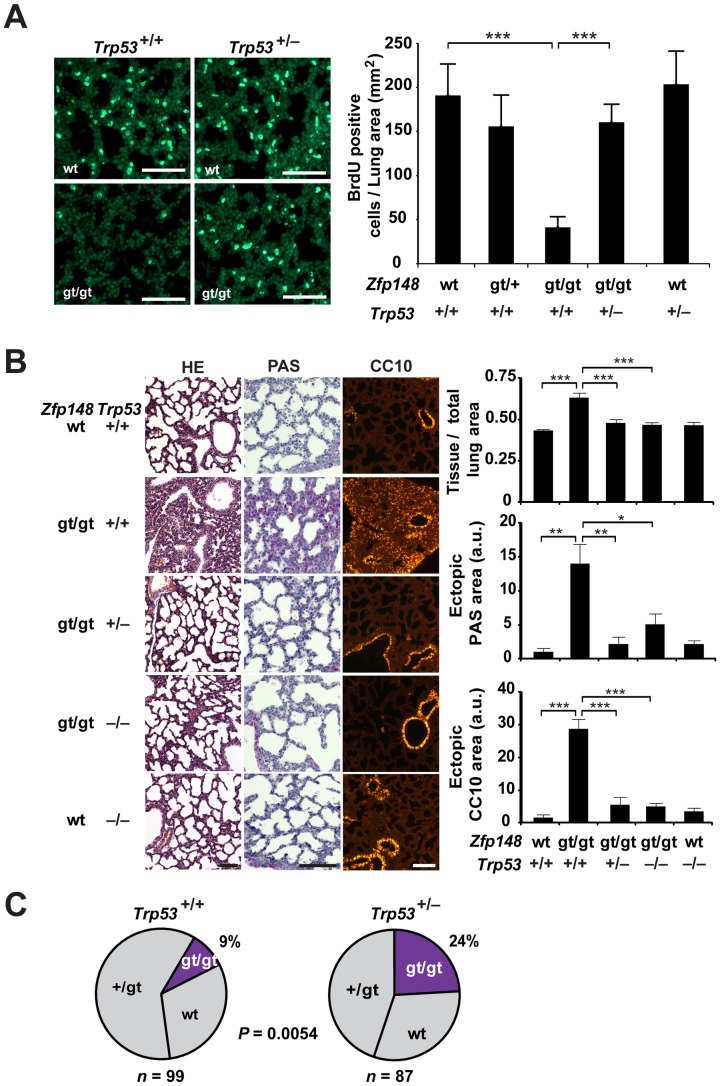
Deletion of one or two copies of Trp53 rescued Zfp148gt/gt mice from proliferation arrest, respiratory distress and neonatal lethality.(A) Photomicrographs showing BrdU labeling of E19.5 lung from wt, Zfp148gt/gt, Zfp148gt/gtTrp53+/− and Trp53+/− mice. Graphs show quantification of BrdU positive cells per lung area (n = 6 wt, 7 Zfp148+/gt, 7 Zfp148gt/gt, 5 Zfp148gt/gtTrp53+/−, 4 Trp53+/−). (B) Photomicrographs showing lung morphology (hematoxylin and eosin; HE) and glycogen content (periodic acid-Shiff; PAS) and CC10 immunofluorescence in P1 lungs from Zfp148+/+Trp53+/+ (n = 10), Zfp148gt/gtTrp53+/+ (n = 9), Zfp148gt/gtTrp53+/− (n = 9), Zfp148gt/gtTrp53−/− (n = 5), and Zfp148+/+Trp53−/− (n = 10) mice, respectively. Graphs show quantification of mean tissue area per total lung area, PAS-positive area with bronchioles excluded, and CC10-positive area with bronchioles excluded. (C) Distribution of Zfp148 genotypes of P1 pups of intercrosses between Zfp148+/gtTrp53+/+ and Zfp148+/gtTrp53+/− mice. Scale bars, 100 µm. *P<0.05, **P<0.01, ***P<0.001.